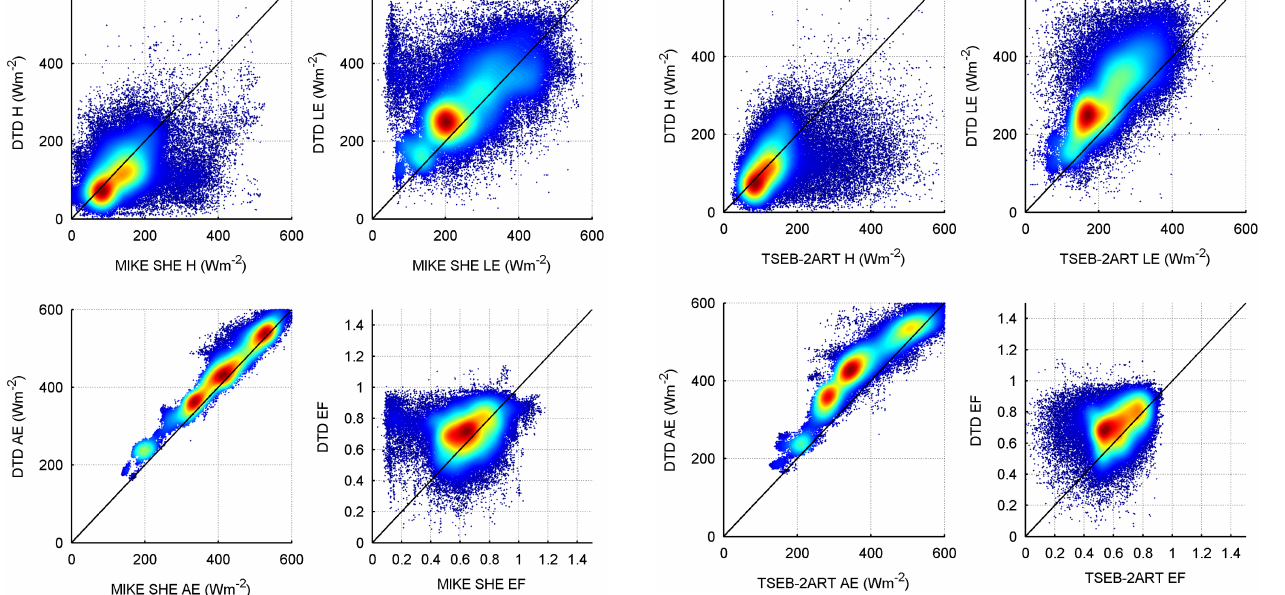
Figure 2. Density scatter plot of over 95000 points comparing the sensible heat flux (top left), latent heat flux (top right), available en- ergy (bottom left) and evaporative fraction (bottom right) modelled by MIKE SHE and DTD. Red colour indicates higher density of points, blue colour lower density.